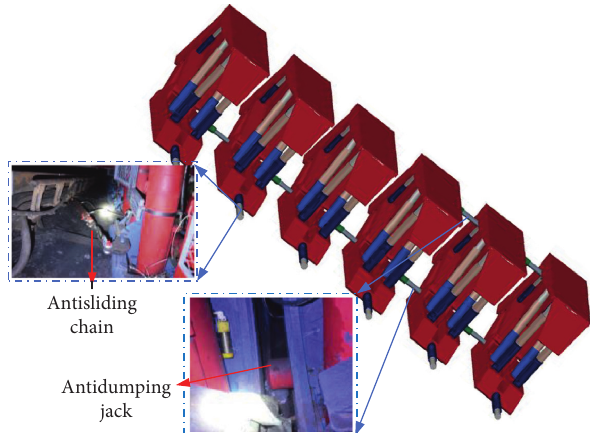
Figure 20: Antisliding and antidumping measures for hydraulic